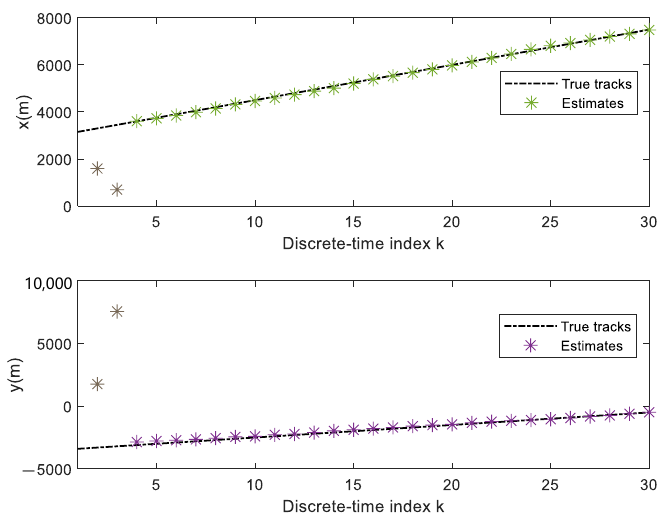
Figure 9. True and estimated x and y coordinates versus time for a single